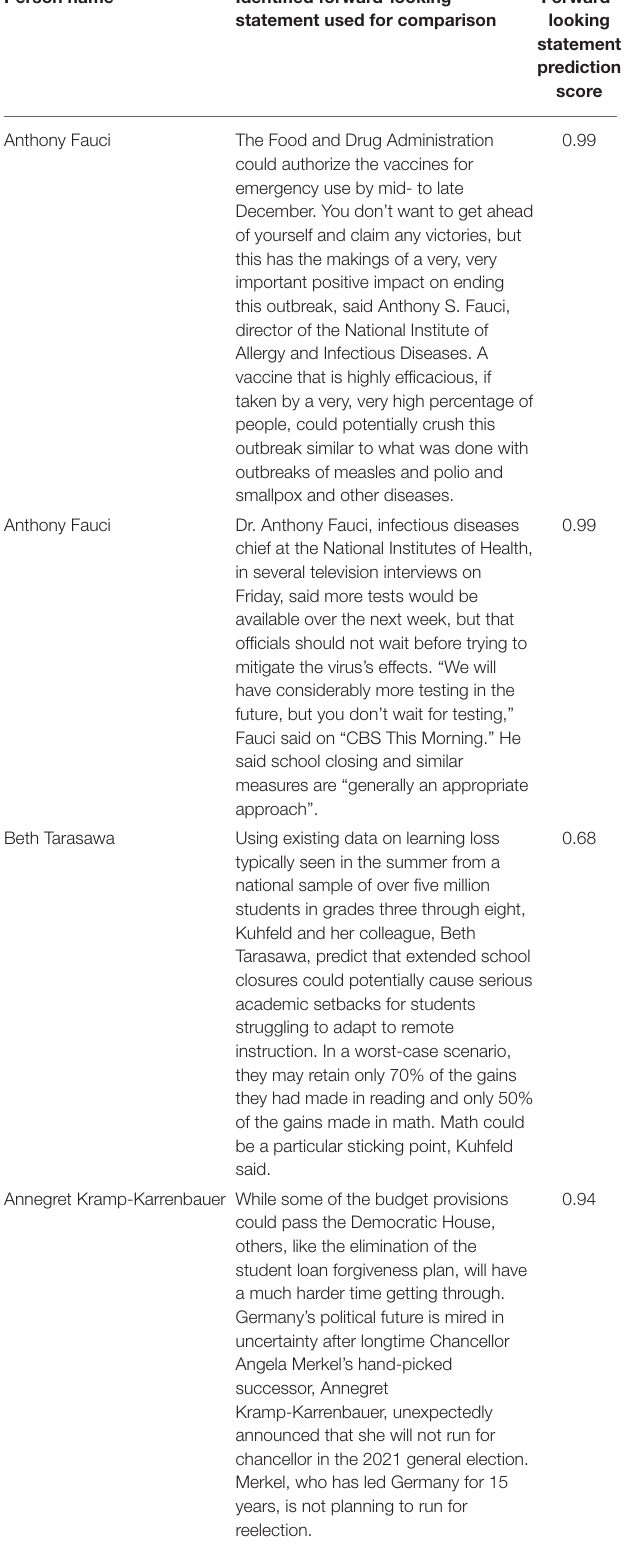
TABLE 6 | Exemplary statements extracted by the algorithm and prediction